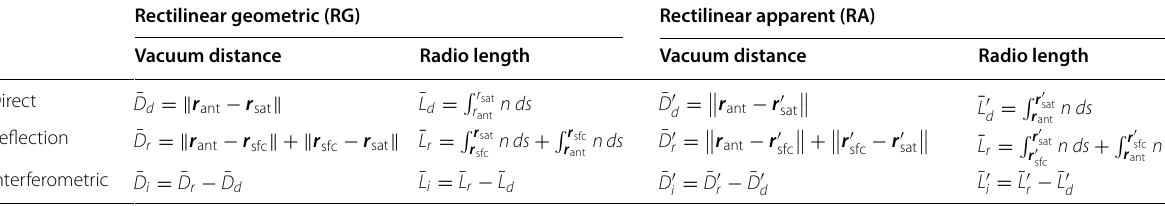
Table 3 Definition of rectilinear propagation quantities Rectilinear geometric